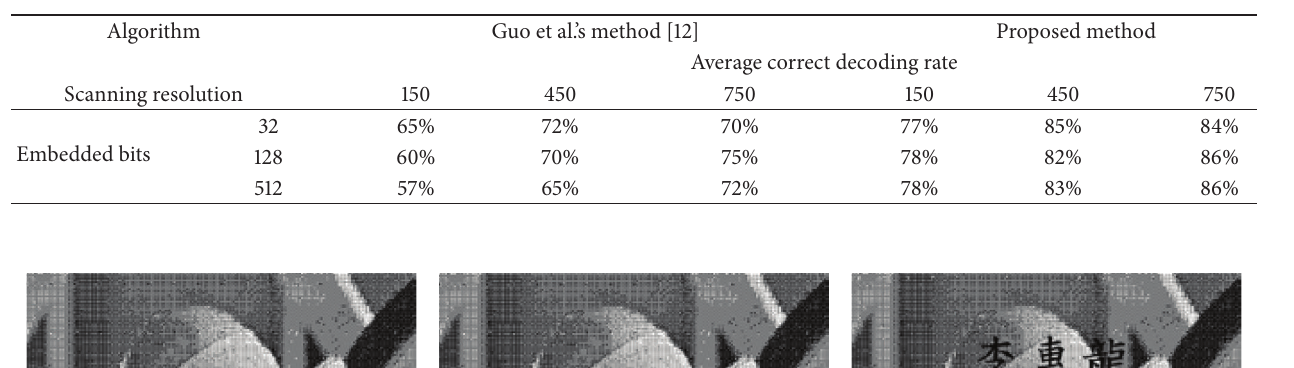
Table 10: Average correct decoding rates of all scanned embedded images with different scanning resolutions.